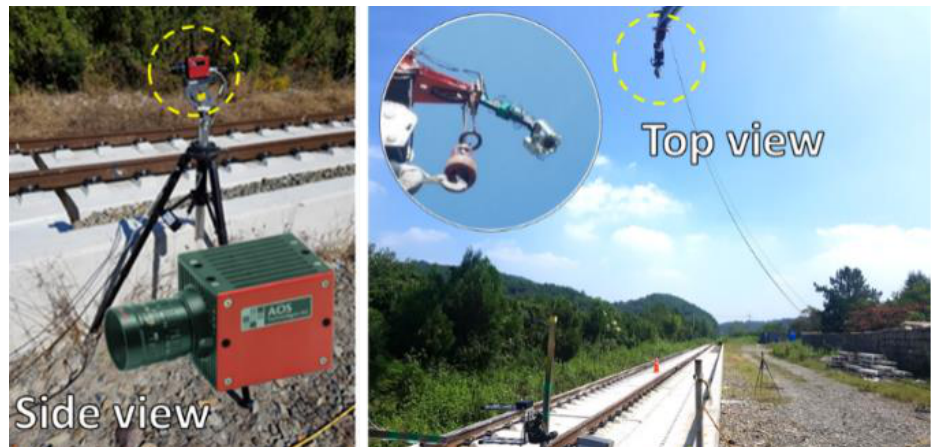
Figure 9. High-speed cameras.